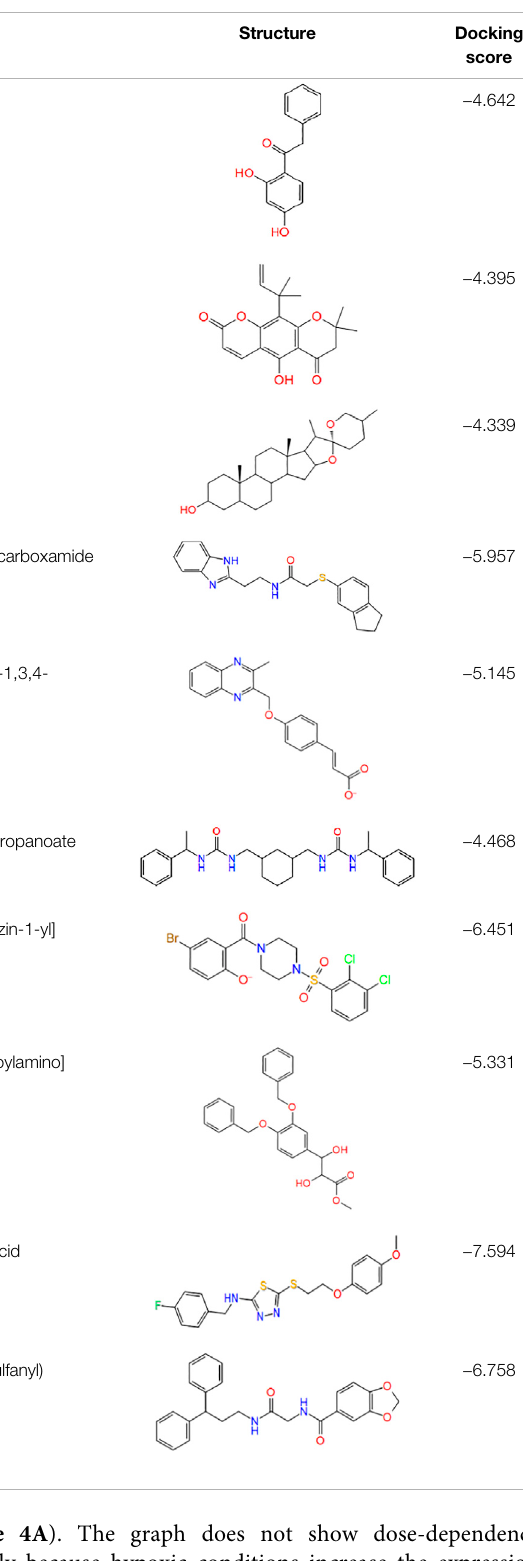
TABLE 1 | ( Continued ) Potential hit compounds obtain by virtual